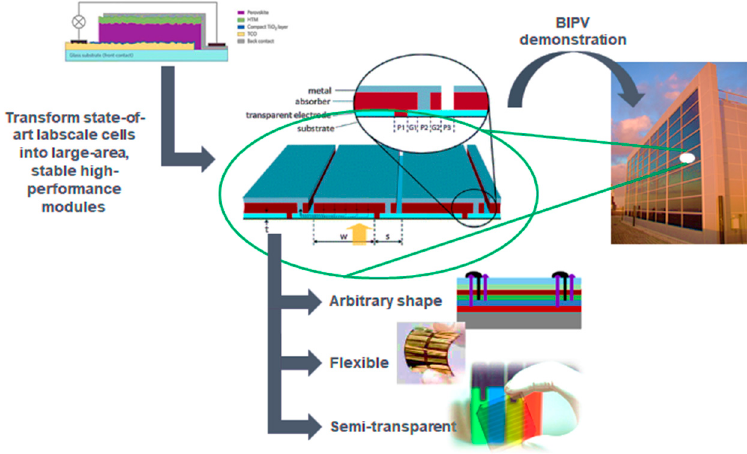
Figure 7. Schematic represents of efficient structures and processes for reliable PSC modules for BIPV application. Reproduced with permission [196].